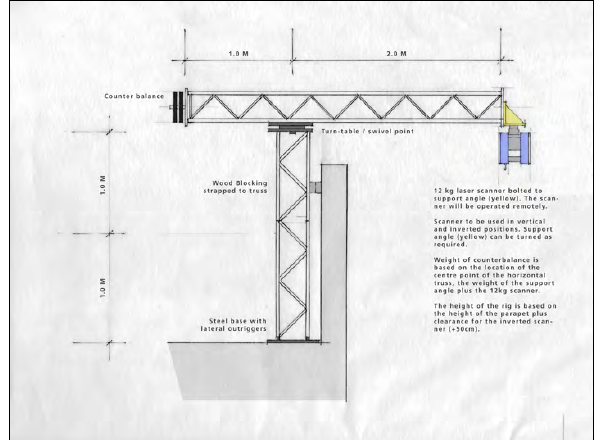
Image 2: Preliminary design sketch of the laser scanner extension